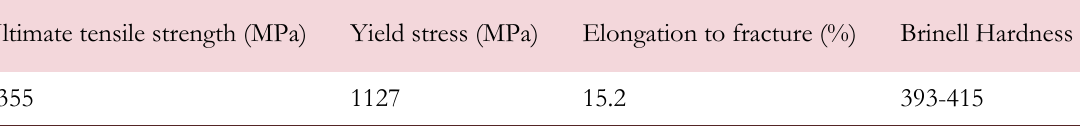
Table 1: Mechanical properties of 40CrMoV13.9.